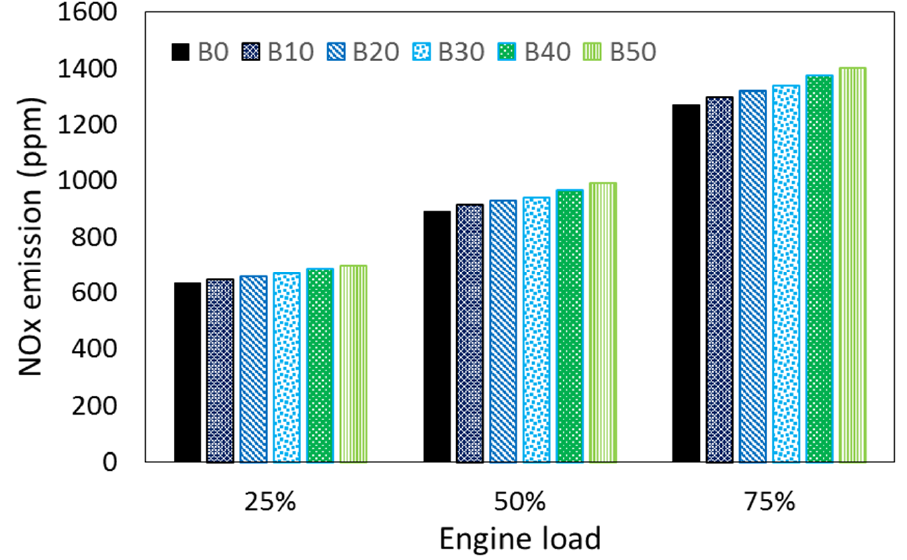
Figure 10. Effect of biodiesel on NOx emission.